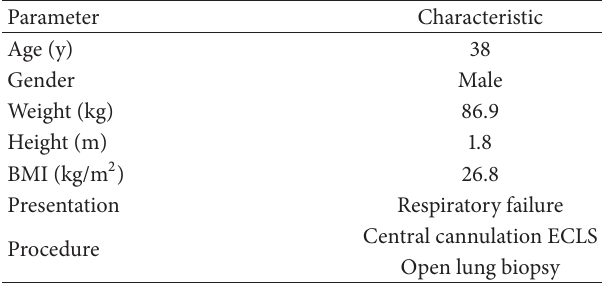
Table 1: Patient